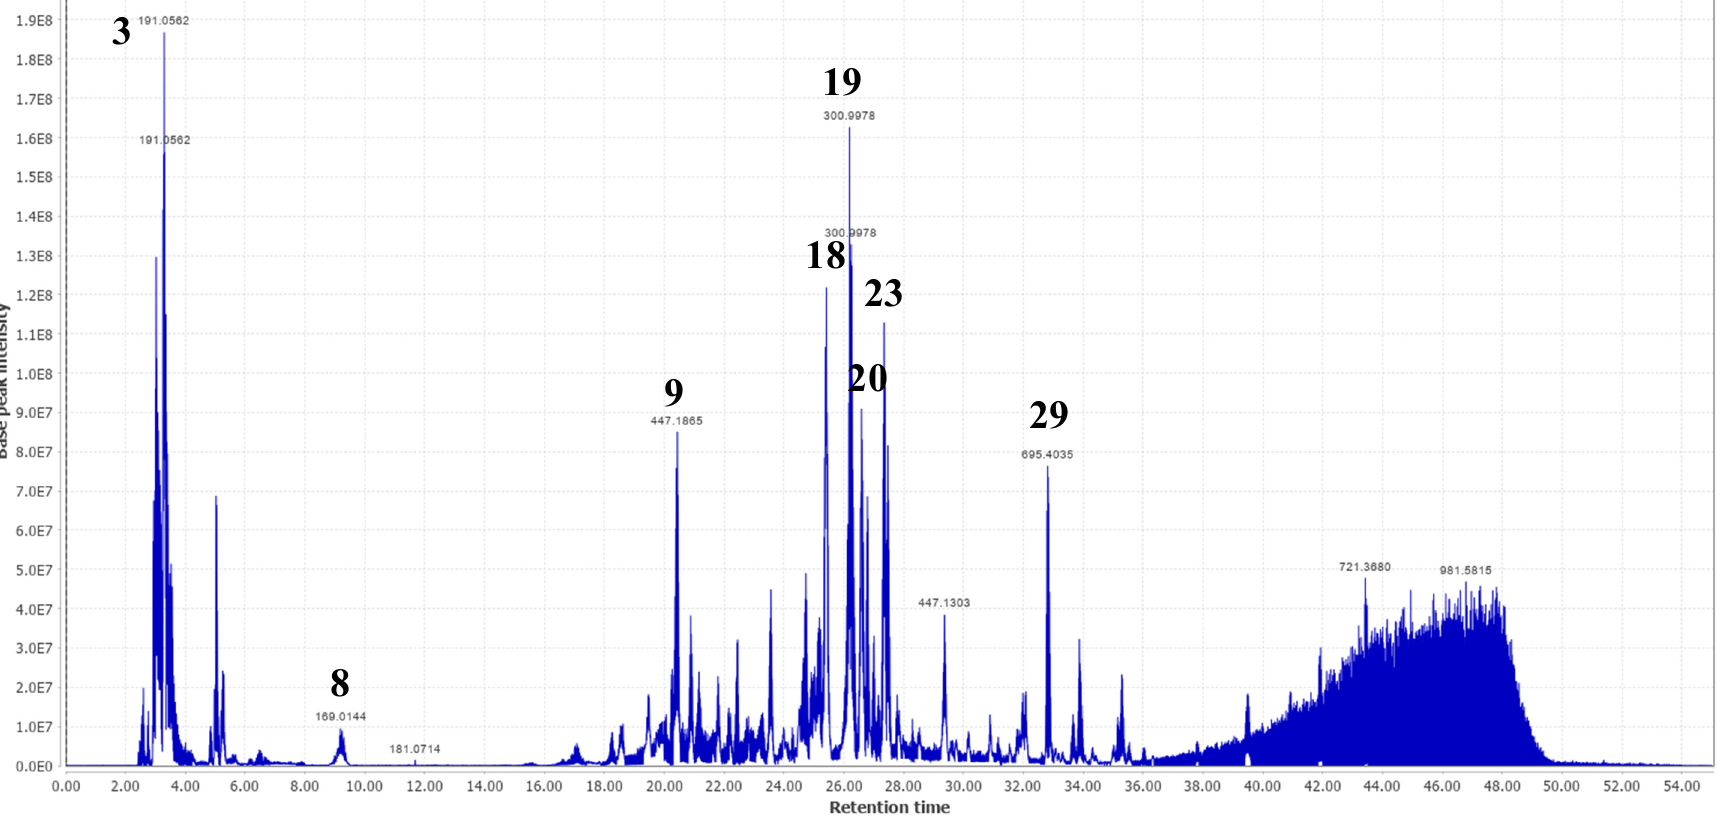
Figure 3. Base peak intensity (BPI) chromatogram of fraction 9 of the MeOH extract of Terminalia leiocarpa showing the main compounds identified. ( 3 ) Quinic acid; ( 8 ) gallic acid; ( 9 ) ellagic acid derivative; ( 18 ) quercetin-3- O -(6- O -galloyl)- β -D-galactopyranoside or isomer; ( 19 ) ellagic acid; ( 20 ) quercetin-3- O -glucuronide; ( 23 ) astragalin, and ( 29 ) rosamultin or isomer.